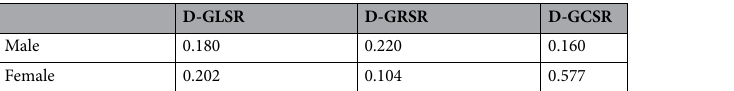
Table 4. The correlation of − dP/dtmax with diastolic strain parameters. D-GLSR diastolic global longitudinal strain rate, D-GRSR diastolic global radial strain rate, D-GCSR diastolic global circumferential strain